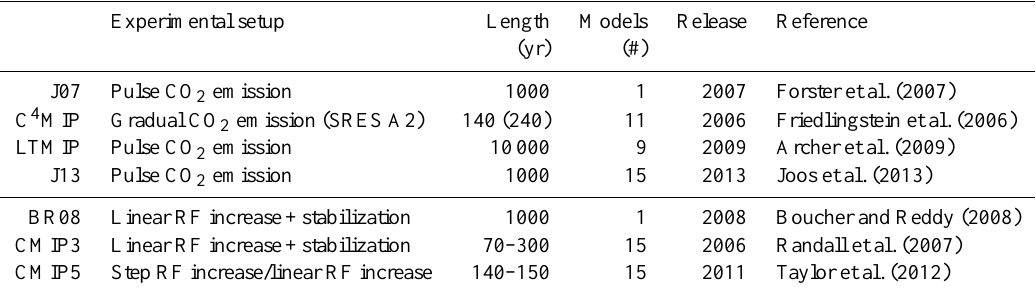
Table 2. Overview of the different data sets used to derive IRF CO number of models participating in the intercomparison exercise.